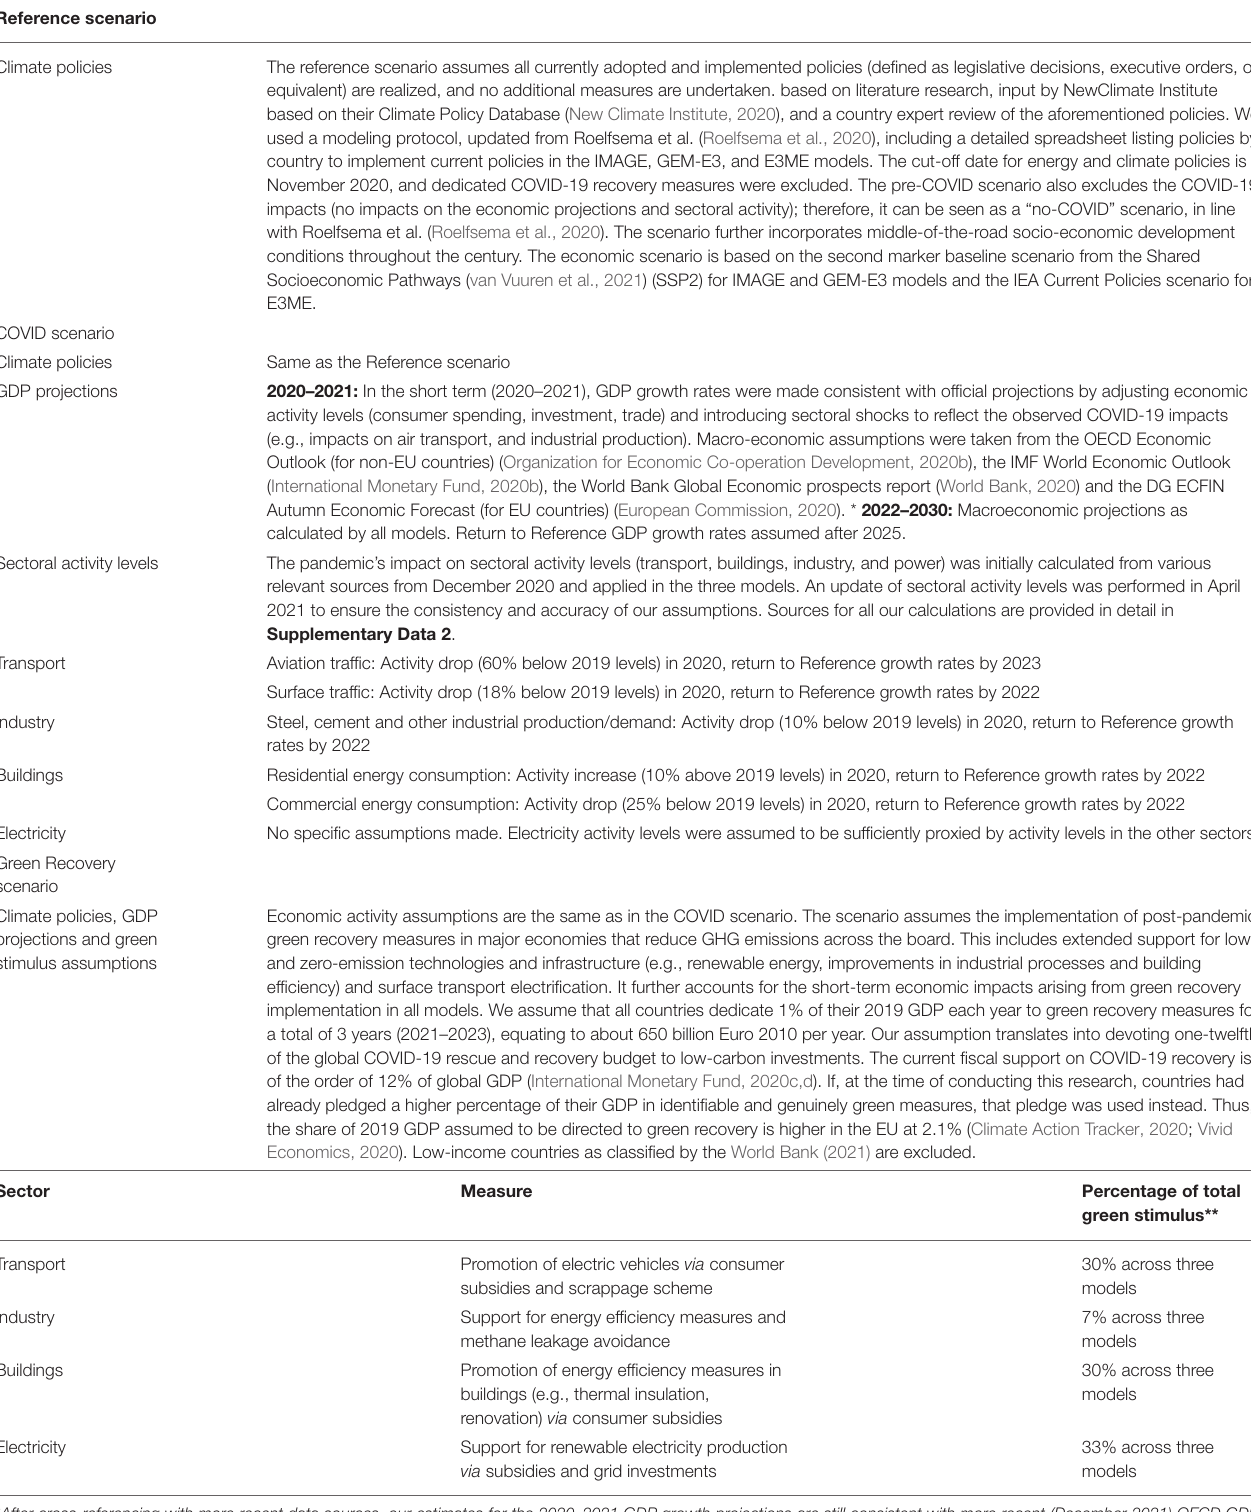
TABLE 1 | Main assumptions and measures implemented per sector for the Reference, COVID and Green Recovery